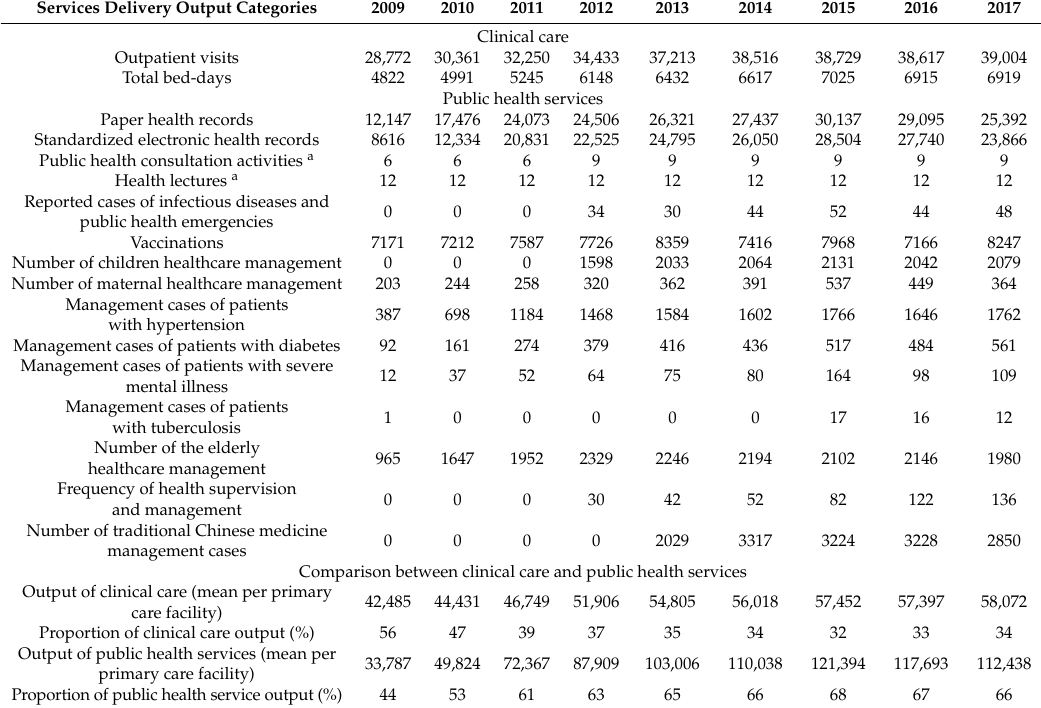
Services Delivery Output